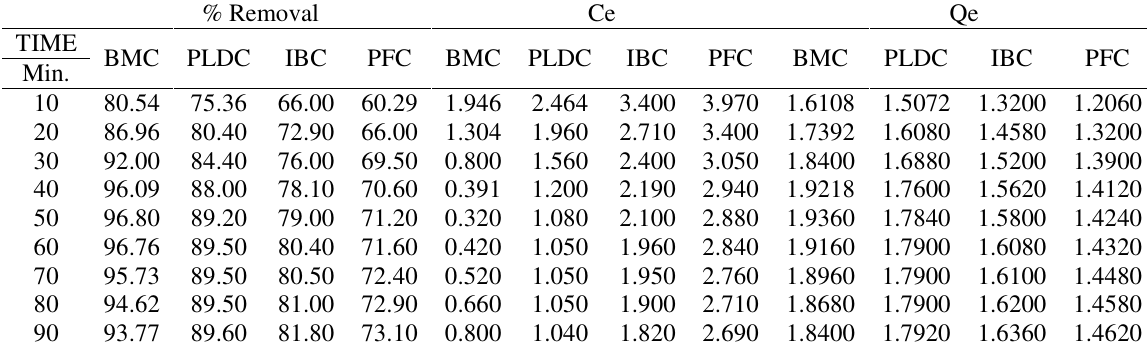
Table 3. Effect of agitation time on the percent removal of Mn(II) by adsorption with prepared AC.